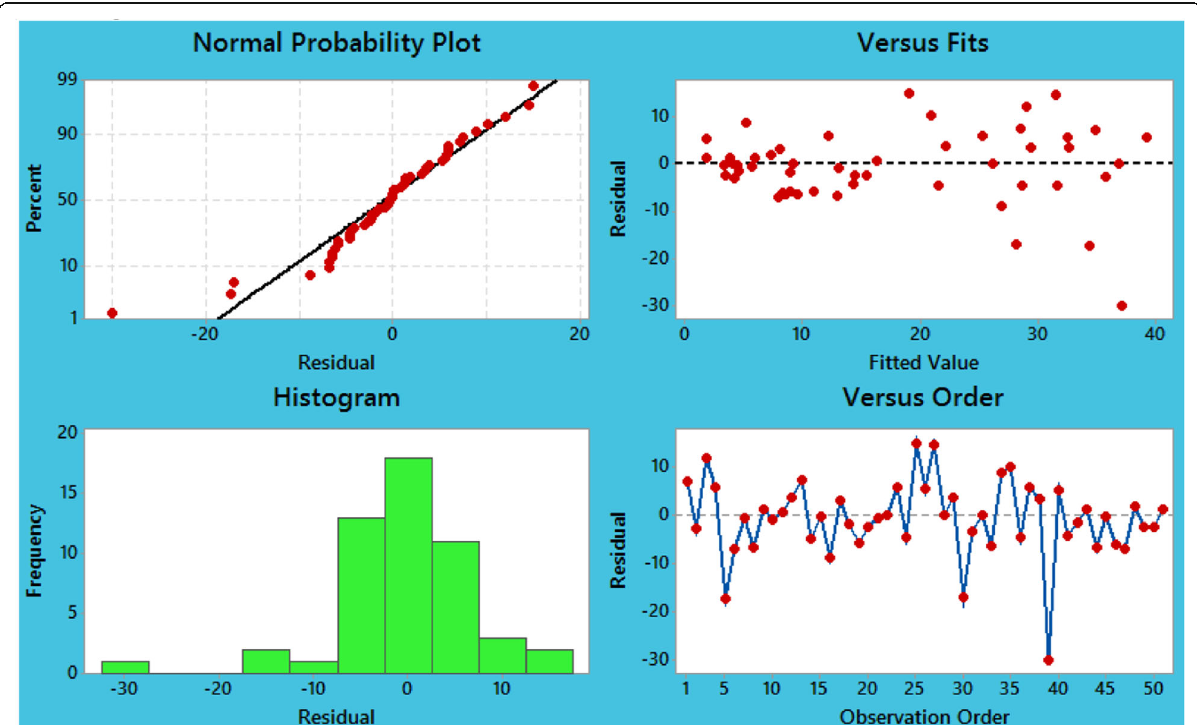
Fig. 7 Plot of residual versus fitted values, histogram of residuals, normal probability plot, and plot of residual versus ordered times for scorpion